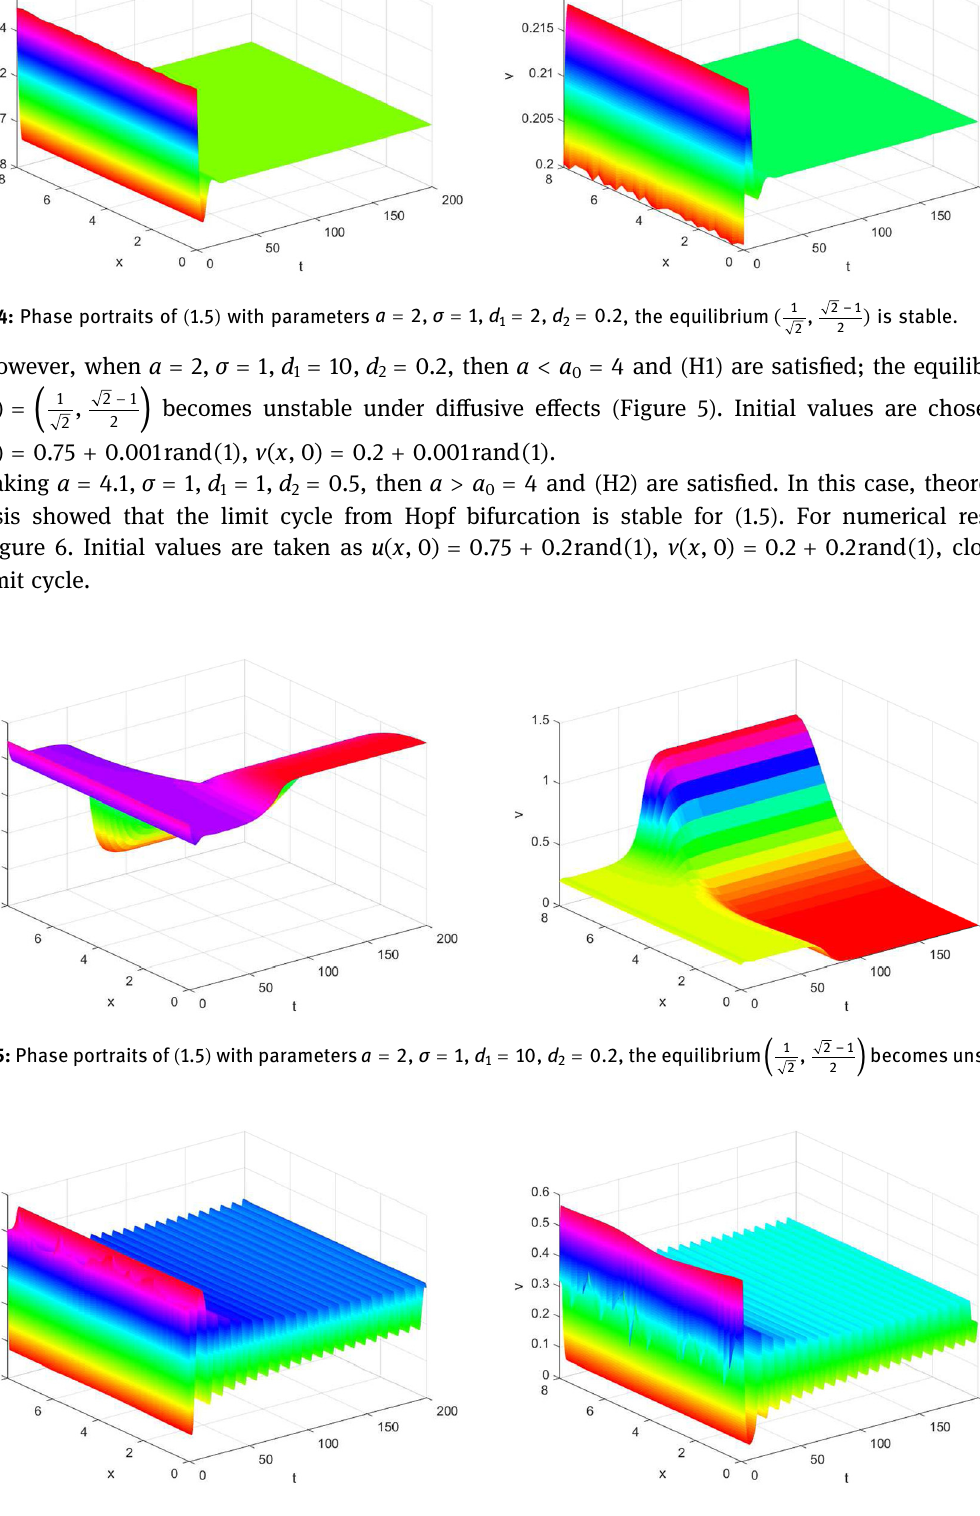
Figure 6: Phase portraits of ( 1.5 ) with parameters = . Bifurcated homogeneous periodic solution is